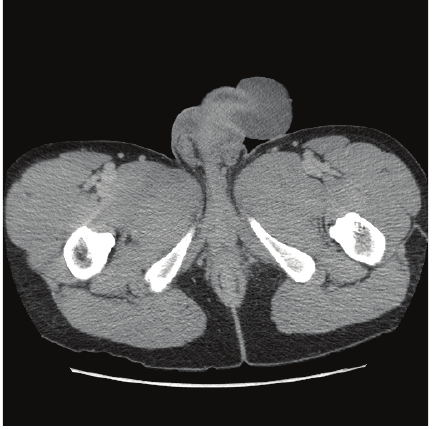
Figure 2: Contrast CT scan of the pelvis of Case 2. CT scan showed diffuse edematous thickening of the skin of the penis without evidence of focal fluid collection or